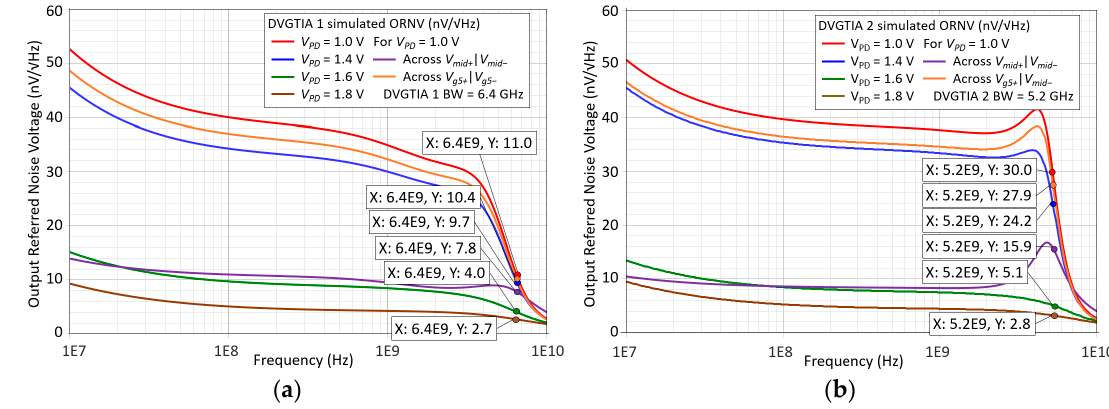
Figure 11. ( a ) Post-layout simulation in Cadence of the output referred noise voltage at TIA bandwidth as well as noise contribution at V mid (output of input stage) and V g 5 (output of gain stage) of DVGTIA design 1 and ( b ) DVGTIA design 2 with (cid:1848) (cid:3017)(cid:3005) at 1 V, 1.4 V, 1.6 V and 1.8 V . Taking the ORNV in Figure 11 and the maximum gains at (cid:1848) (cid:3017)(cid:3005) = 1V in Figure 9, the input-referred noise current (IRNC) of DVGTIA designs 1 and 2 are calculated to be 10.3 (cid:1868)(cid:1827)/√(cid:1834)(cid:1878) and 21.7 (cid:1868)(cid:1827)/√(cid:1834)(cid:1878) at bandwidths 6.4 GHz and 5.2 GHz respectively. Hence by taking SNR = 49 and multiplying √(cid:1834)(cid:1878) at bandwidth operation, the minimum input current needed is calculated as 40.4 µA and 76.8 µA for the lower limit of the input dynamic range of DVGTIA designs 1 and 2 respectively.